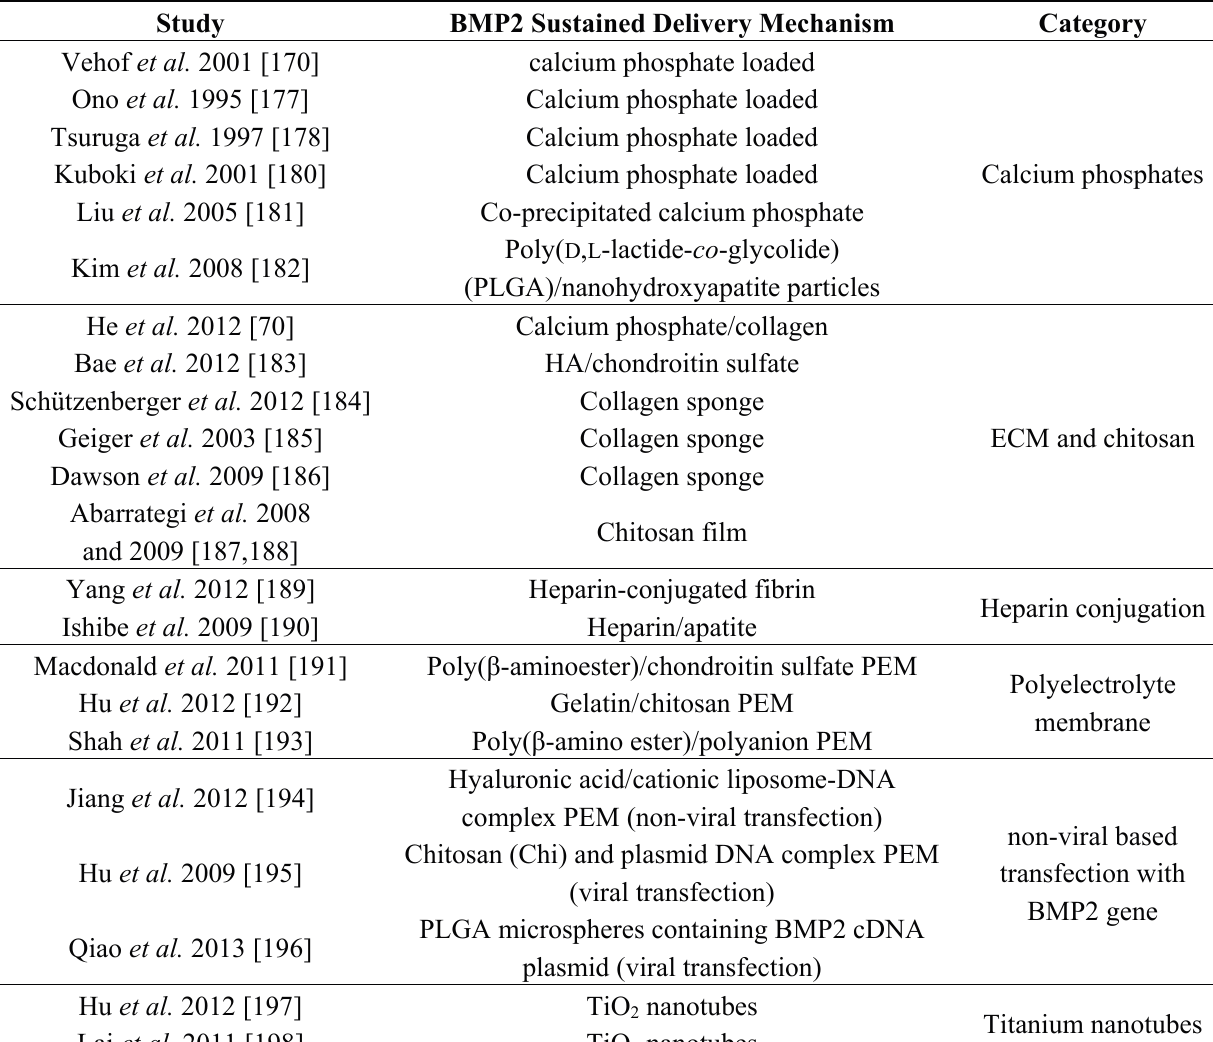
Table 1. Various BMP2 (bone morphogenetic protein 2) sustained released mechanisms that can be engineered into metallic implants to promote osteoinduction. HA, hydroxyapatite; PEM, poly-electrolyte membranes; ECM, extracellular matrix